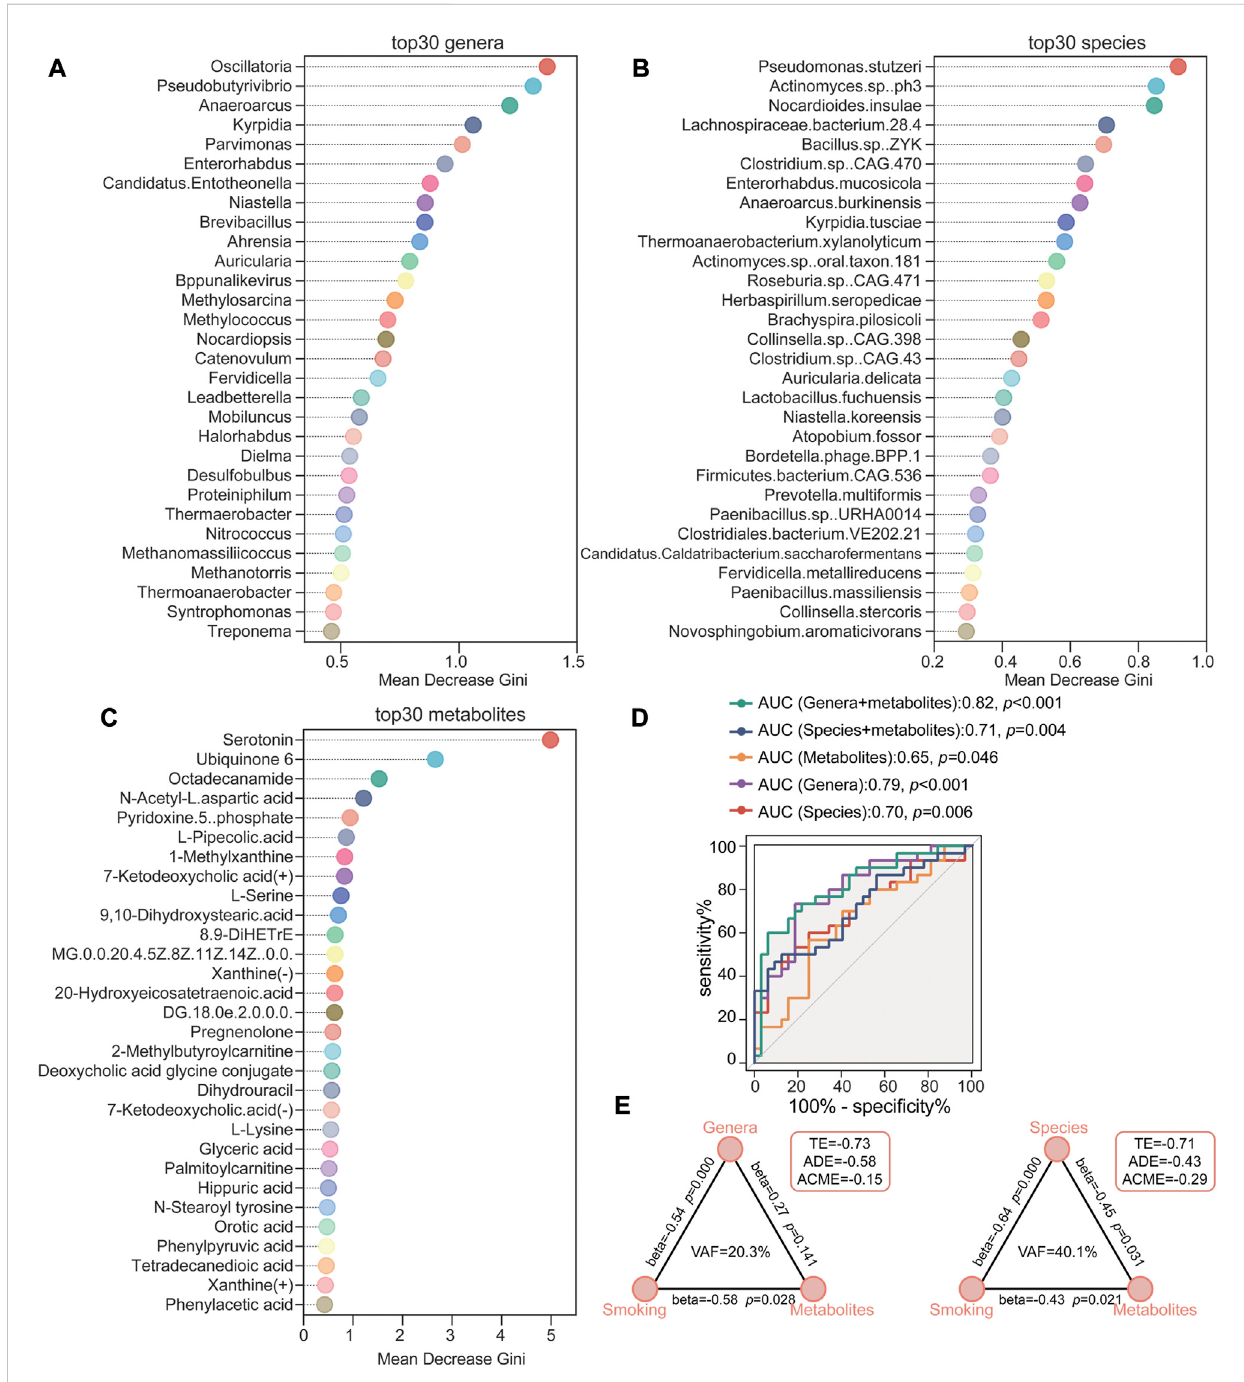
FIGURE 7 Random forest classi fi cation based on gut microbiome and metabolites to identify HTN-S patients from HTN-NS controls. (A – C) , Random forest models wereconducted respectively to evaluate thepotential of fecal genera/species and serum metabolites to discriminate between HTN-S and HTN- NS. The top 30 most distinguishing genera/species and metabolites between HTN-S and HTN-NS in the random forest analysis. Mean decrease Gini shown on the x -axis indicates the importance of each variable (genera, species or metabolites) for the classi fi cation. (D) , Receiver operating characteristic(ROC)curvesshowedthesensitivity,speci fi cityandareaunderthecurve(AUC)withexplanatoryvariablesofthetop30mostdistinguishing genera, species or metabolites to distinguish smoking HTN patients from non-smoking individuals. (E) , The mediation effects of top 30 most distinguishing gut genera/species (indirect effect) on the total effect of smoking on top 30 metabolites. Path coef fi cients (beta) are labeled beside each path and indirect effect (VAF score) are denoted below each mediator variables. TE, total effect; ADE, average direct effect; ACME, average causal mediation